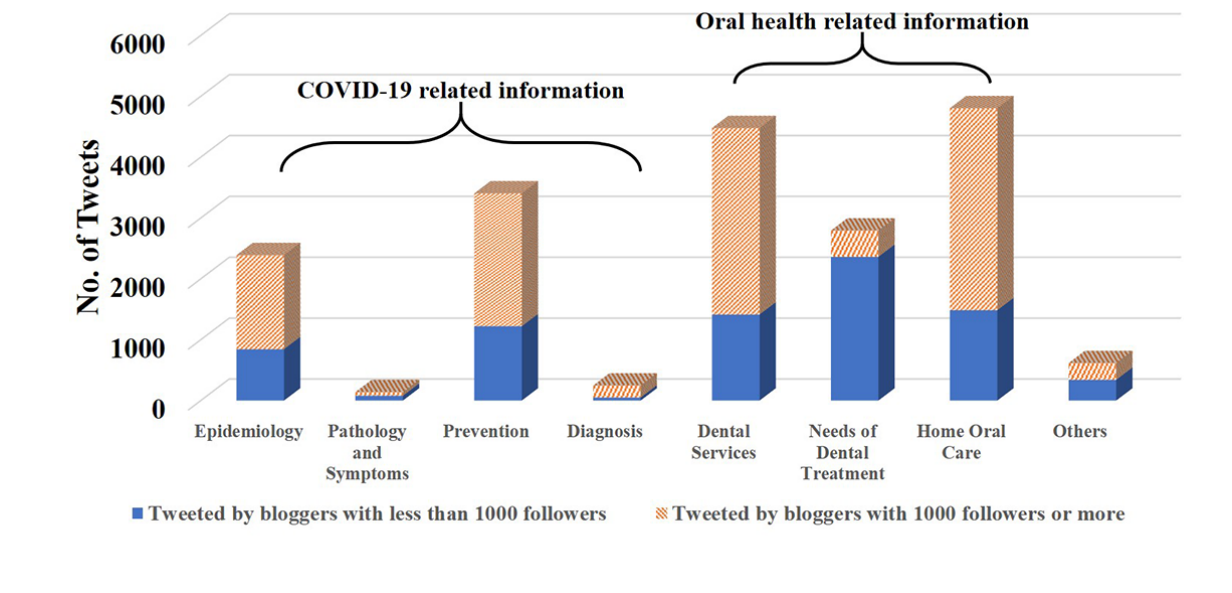
Figure 4. Thematic distributions of tweets with COVID-19–related oral health information. COVID-19: coronavirus disease.